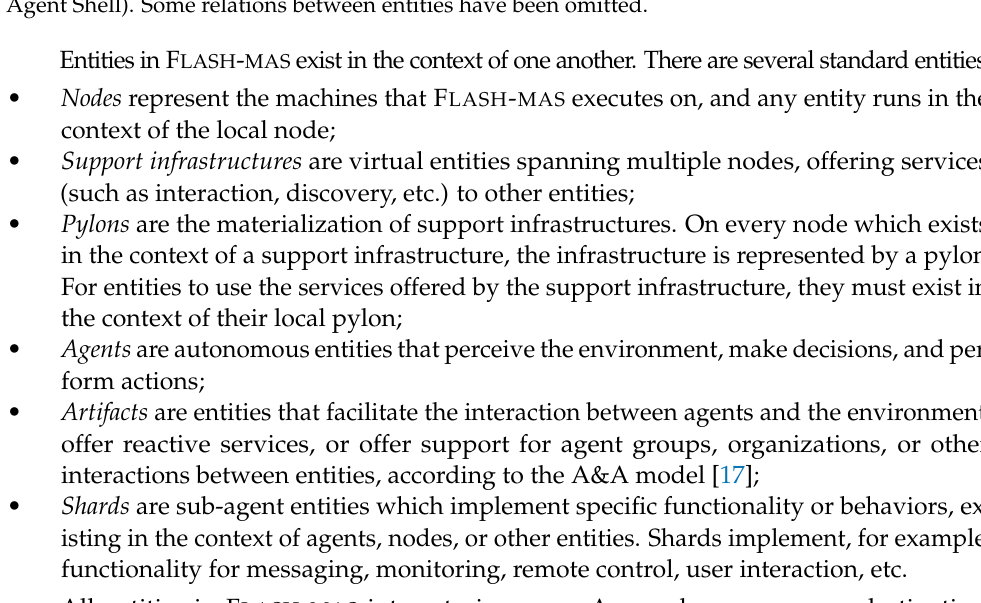
Figure 2. Examples of entities and their interconnections in F LASH - MAS (the Fast and Lightweight Agent Shell). Some relations between entities have been